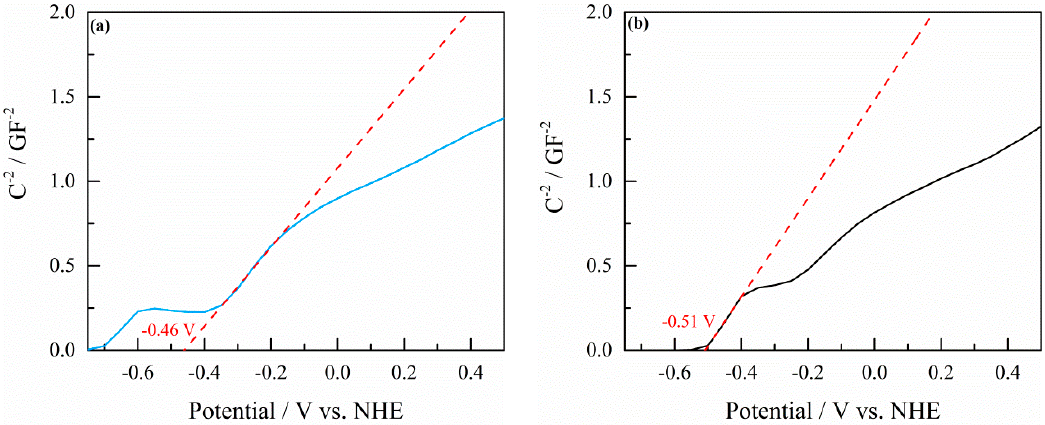
Figure 3. Mott–Schottky plot of ( a ) a K-7000 film and ( b ) a Hombikat UV100 film measured in a 0.1 M KNO 3 solution at a frequency of 100 Hz. The dashed red line shows the extrapolation of the linear part to the ordinate value of zero.